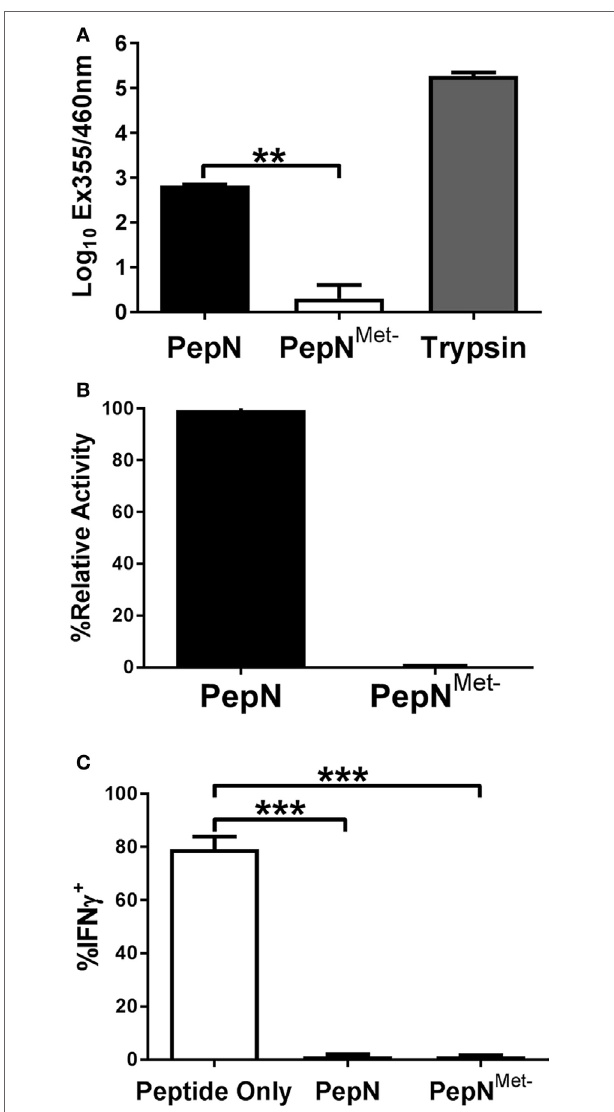
FigUre 7 | The ability of Streptococcus pneumoniae ( Spn ) aminopeptidase N (PepN) to inhibit NP-specific cytotoxic T lymphocyte (CTL) effector function is independent of its enzymatic activity. The enzymatic activity of wild-type PepN and PepN Met − was tested by incubation with lys-AMC. Raw absorbance values from three independent experiments are shown in (a) . The average of values normalized to the level of activity observed using wild-type PepN (plotted as % relative activity) is shown in (b) . In (c) , NP-specific CTL were stimulated in the presence of PepN or PepN Met − . Cells were stained with anti-CD8 and anti-IFN γ antibodies following the stimulation period. Averaged data ± SEM from three independent experiments assessing the inhibitory activity of each protein is shown. ** p < 0.01 and *** p <